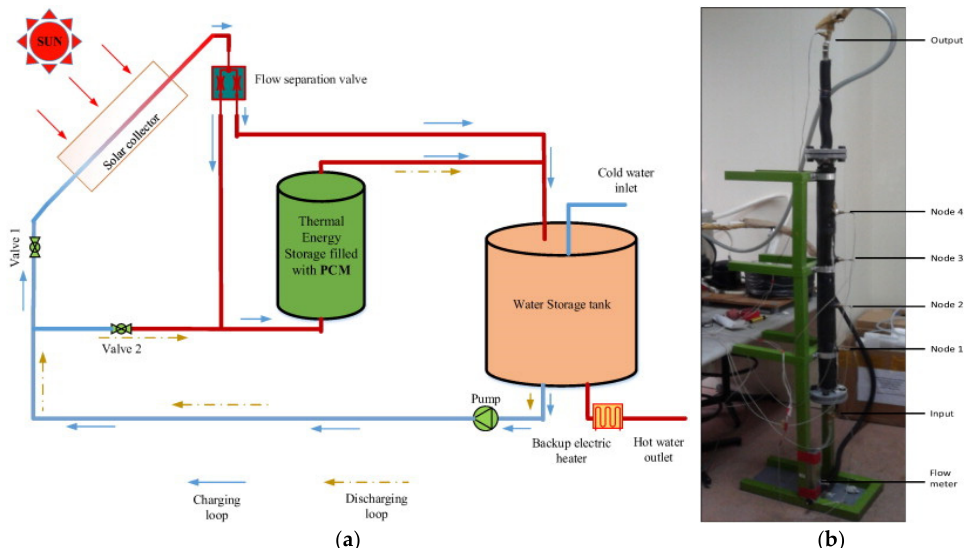
Figure 14. ( a ) Schematic of a solar hot water system with separate LHTES studied in [44] and ( b ) photograph of the LHTES used in [44].